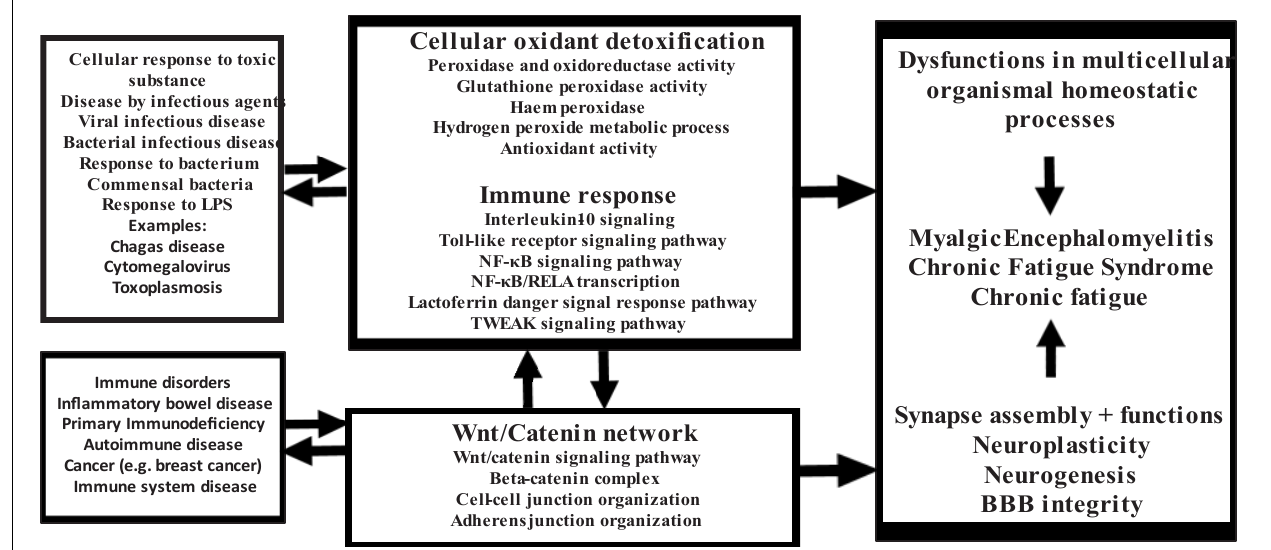
FIGURE 7 | Summary of the findings in this study. LPS: lipopolysaccharides, NF- κ B: nuclear factor- κ B, RELA: transcription factor p65, TWEAK: TNF-related weak inducer of